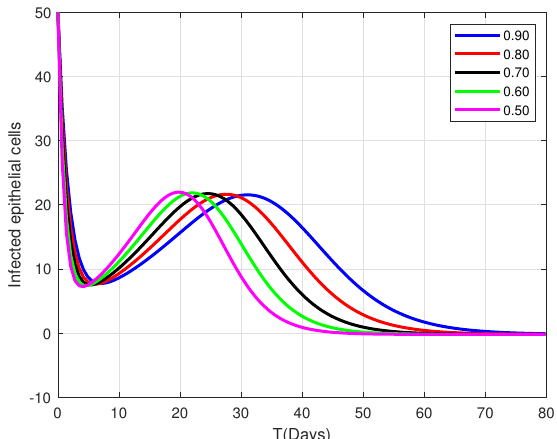
Figure 5. Graphical representation of the approximate solutions of the infected virus epithelial cells for fractional order α = 0.9, 0.8, 0.7, 0.6, 0.5.